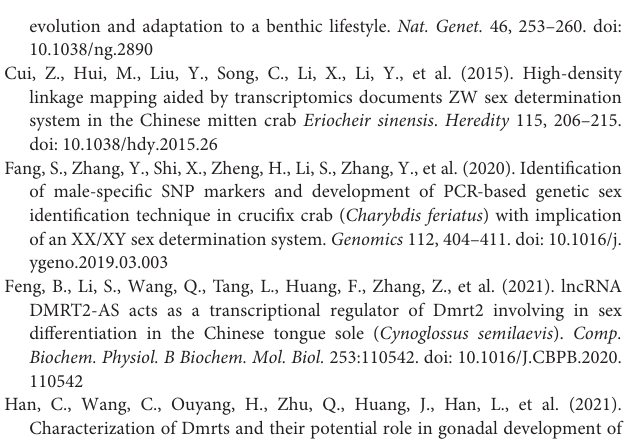
Supplementary Table 2 | Gene information of the 41 genes in the SD region. Supplementary Table 3 | Annotation information for the detected sex-related